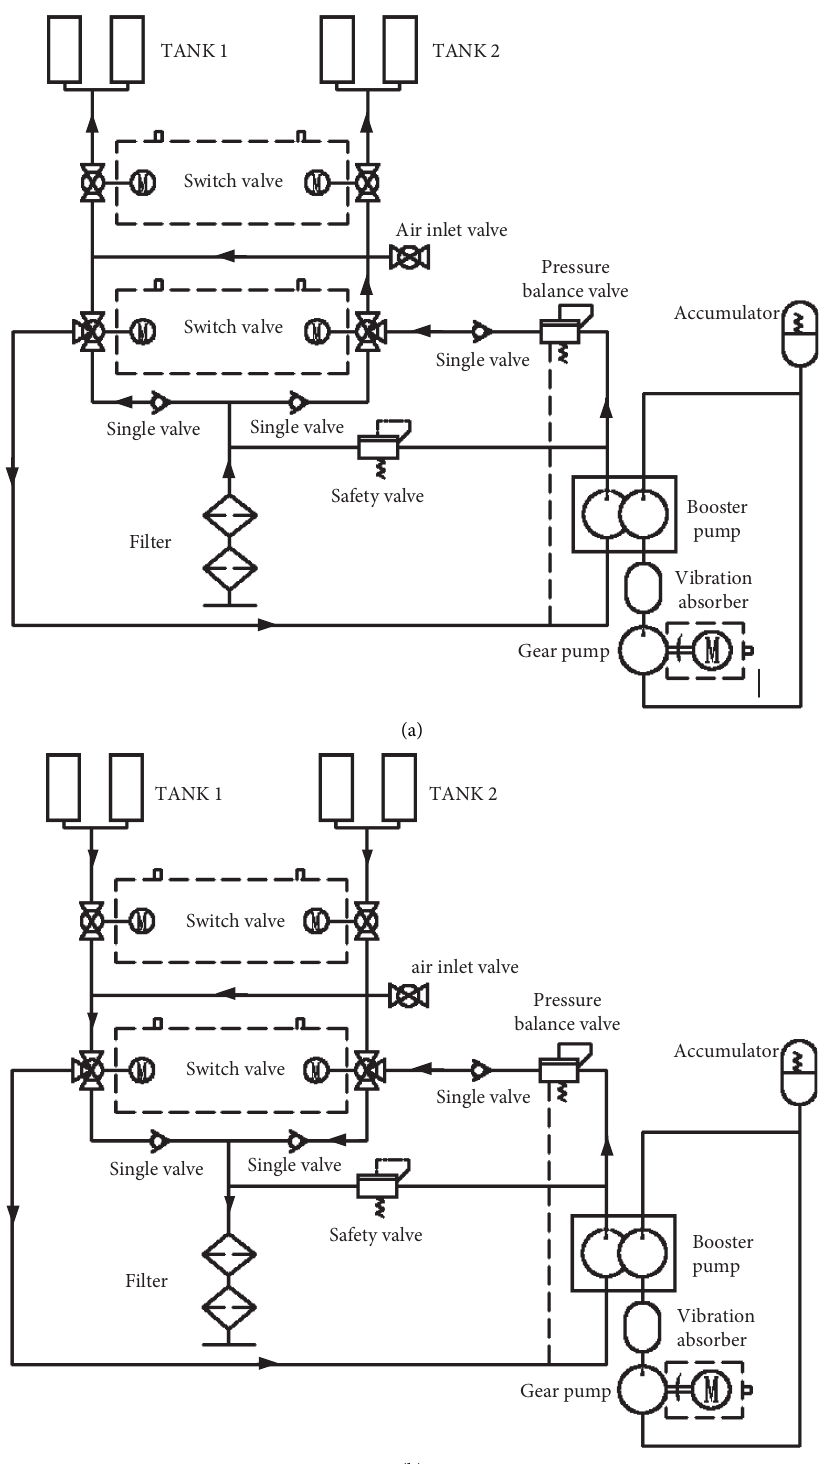
Figure 1: Schematic diagram of the buoyancy regulation system: (a) seawater charging process; (b) seawater discharging